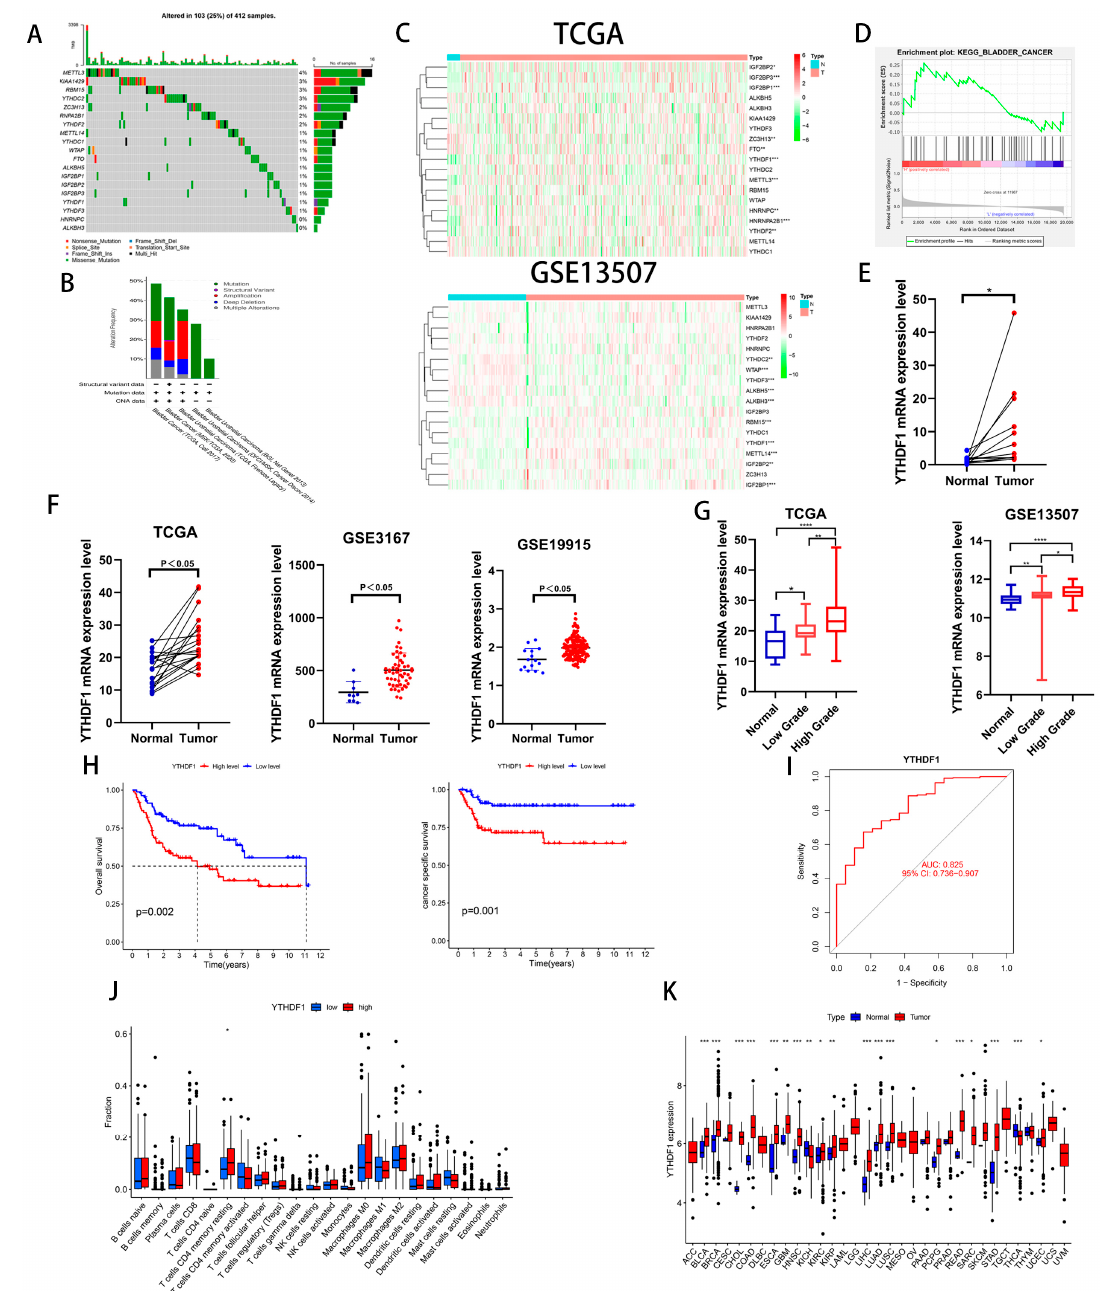
Figure 1. YTHDF1 expression is increased in BLCA and is significantly correlated with prognosis. ( A ) Mutation frequencies of 19 common m6A-related genes in the TCGA bladder cancer database. ( B ) Mutation frequencies of 19 m6A-related genes in the cBioPortal database. ( C ) Heat map analysis of 19 genes in the TCGA database and the GSE13507 dataset. ( D ) Single-gene KEGG enrichment analysis was performed on YTHDF1. ( E ) YTHDF1 mRNA validation of cancer and paracancerous tissues from 12 pairs of BLCA patients collected at our institution. ( F ) YTHDF1 expression validation in TCGA database, GSE3167 and GSE19915 datasets. ( G ) Expression validation of YTHDF1 in the TCGA database and GSE13507 dataset for high and low level BLCA. ( H ) OS and cancer-specific survival analysis of YTHDF1 in the GSE13507 dataset. ( I ) Diagnostic curves analyzed by YTHDF1 in the TCGA database. ( J ) Correlation analysis of YTHDF1 with immune function in the TCGA database. ( K ) Expression analysis of YTHDF1 in the TCGA database for pan-cancer. * p < 0.05, ** p < 0.01, *** p < 0.001, **** p < 0.001 or not significant